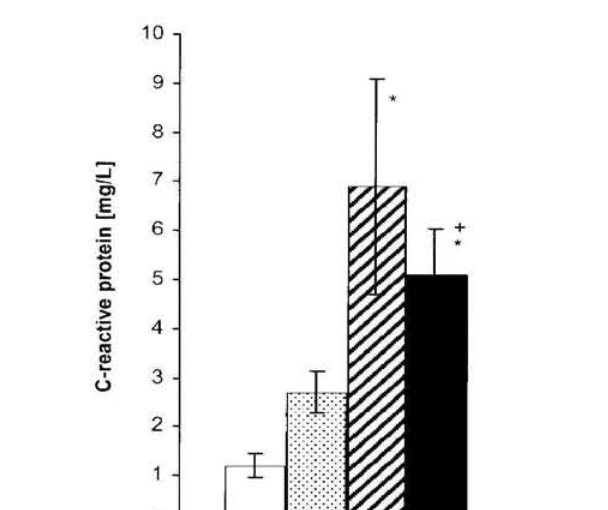
Figure 2. Serum concentration (mean ± S.E.M.) of high sensitivity C-reactive protein in healthy individu- als (open bars) and in CAD patients before percuta- neous transluminal coronary angioplasty due to 1- artery disease (dotted bars), 2- or 3-artery disease (hatched bars), and restenosis (black bars). *The changes arc significant if compared with healthy indi- viduals (P <0.05 - Ρ <0.001 ) or with patients with 1- artery disease (P <0.01